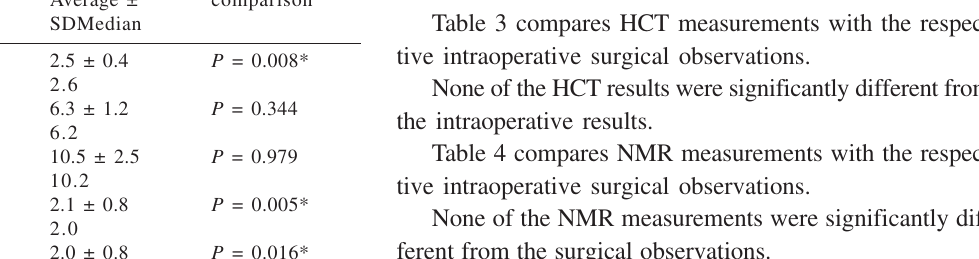
Table 1 - Comparison between ultrasonography measurements (USG) and surgical observation (SO) (n = 20). Region USG